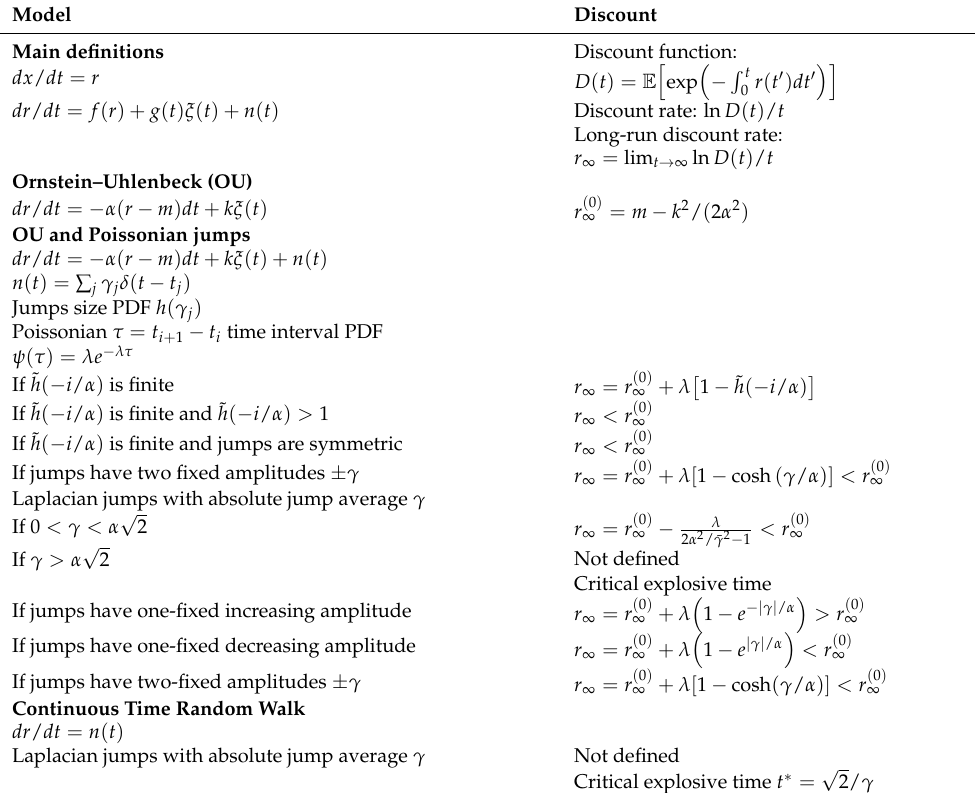
Table 1. Summary of the results proved in Section 3. The Ornstein–Uhlenbeck diffusion process already shows that the presence of noise ( k (cid:54) = 0) reduces the long-run discount rate r of Poissonian jumps with specific scenarios leads to several discount functions D ( t ) and several long-run discount rate r ∞